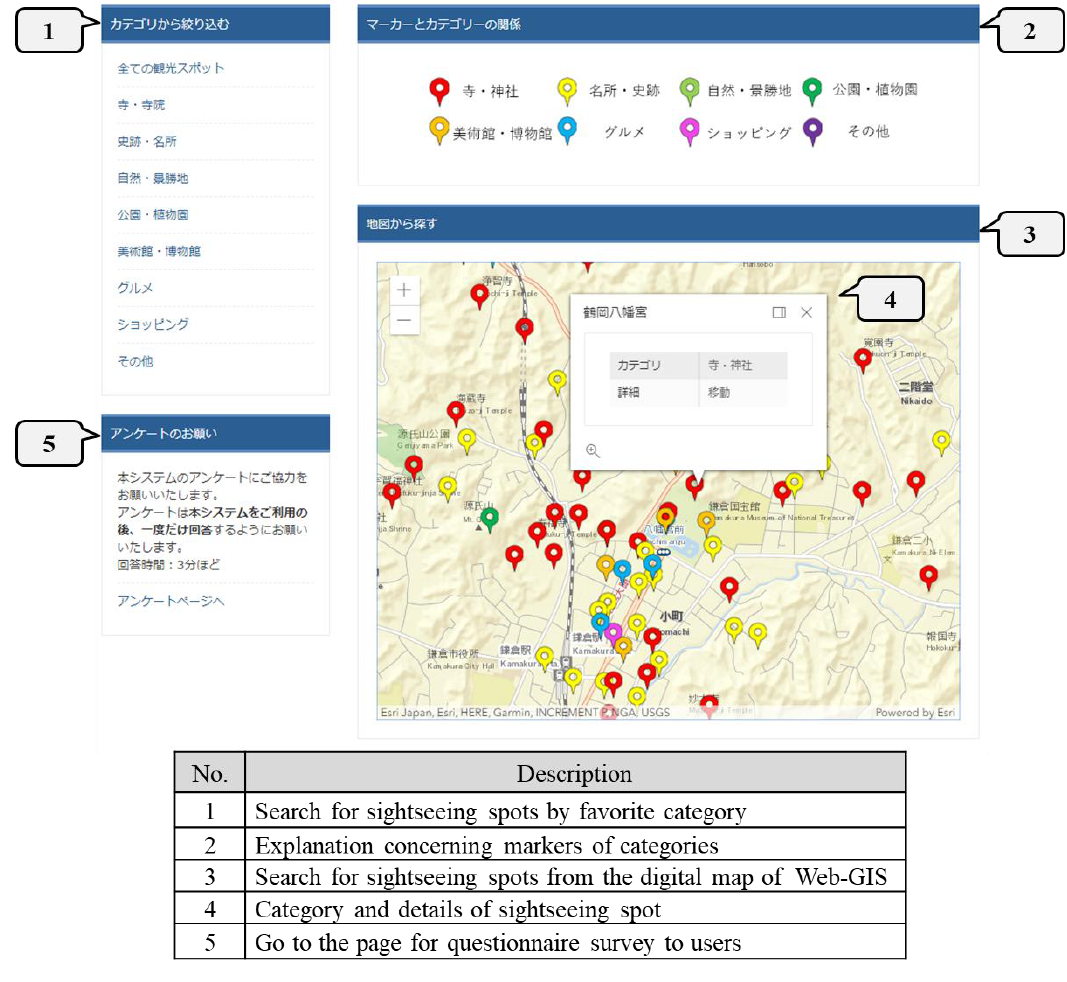
Figure 3. Page for viewing function of sightseeing spots.